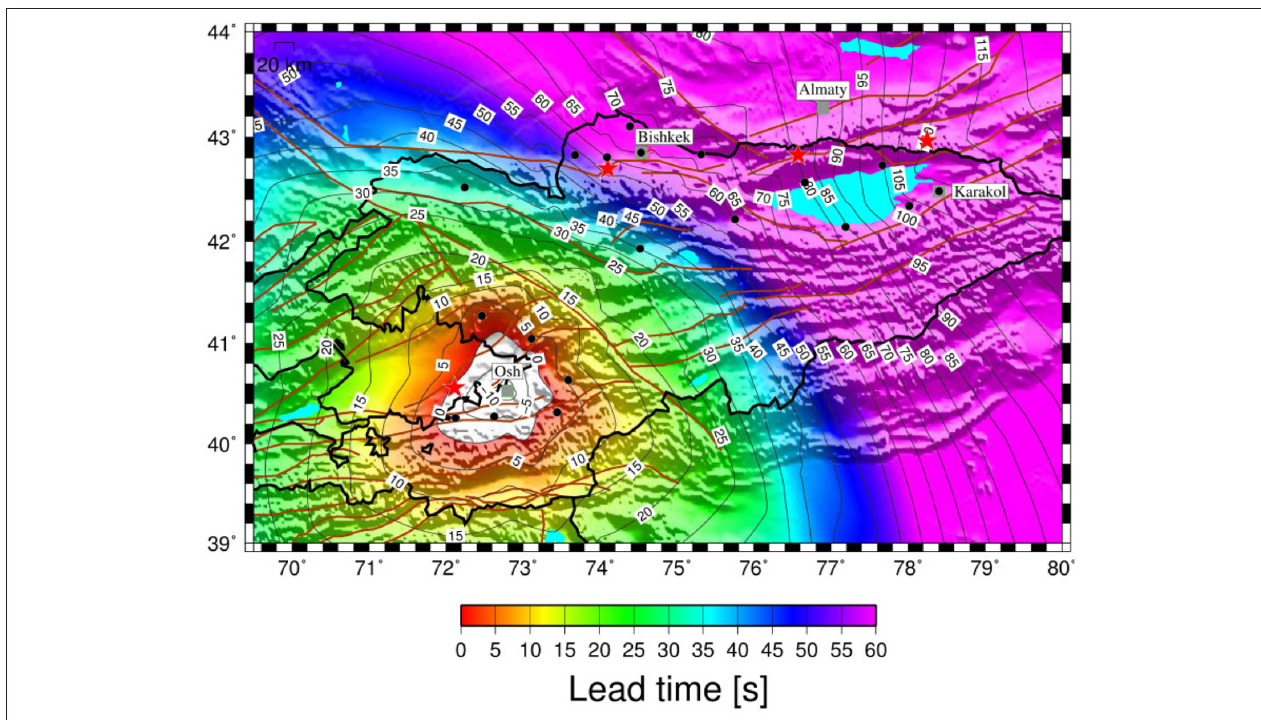
FIGURE 9 | The lead-times for Osh, using a regional approach, as a function of the location of possible seismic events (i.e., a 0.1 by 0.1 ◦ grid). Also shown are the main cities considered in this study (gray squares) and a selection of historical or hypothetical earthquakes (red stars, see Figure 1 and text for explanation). The brown lines indicate the main tectonic alignments and faults existing in the